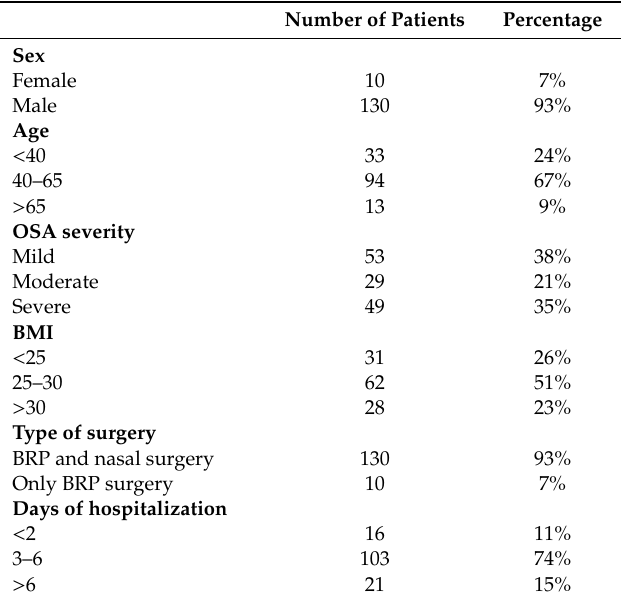
Table 2. Enrolled patients’ characteristics.